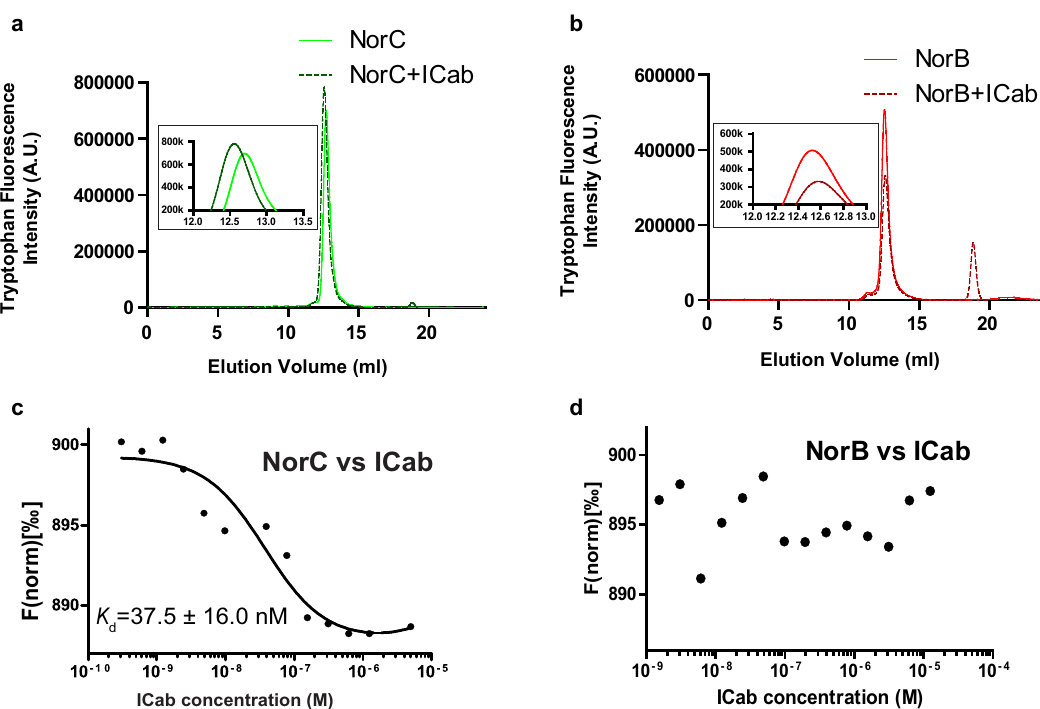
Fig. 3 ICab speci fi cally interacts with NorC. a Tryptophan fl uorescence trace of NorC in FSEC, shifts to a slightly higher molecular mass when complexed with ICab. b NorB does not display a shift indicating a lack of interaction with ICab (inset). c , d Corresponding MST pro fi les of NorC and NorB respectively with K d = 37.5 ± 16 nM for ICab and NorC but no detectable af fi nity for NorB. n = 2 for NorB vs ICab titration and n = 3 for NorC vs ICab for independent replicates. Source data are provided in the source data fi (MST) experiments (Fig. 3a, b). A comparison of the ICab crystal